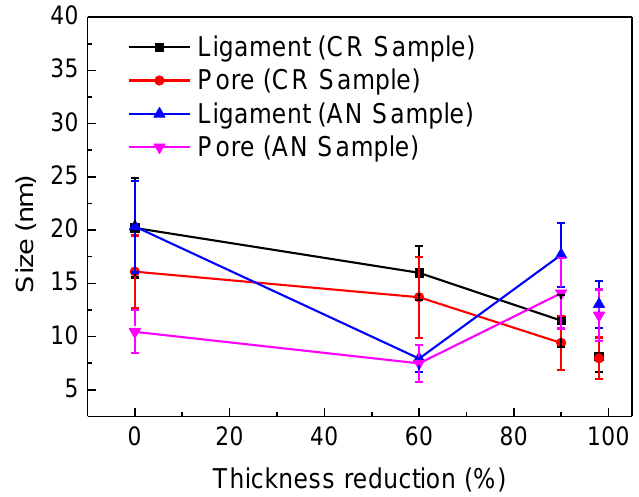
Figure 3. Average ligament and pore sizes of NPG of CR and AN samples as functions of thickness reduction. Table 1. Average ligament and pore sizes of NPG of CR and AN samples for different thickness reduction.